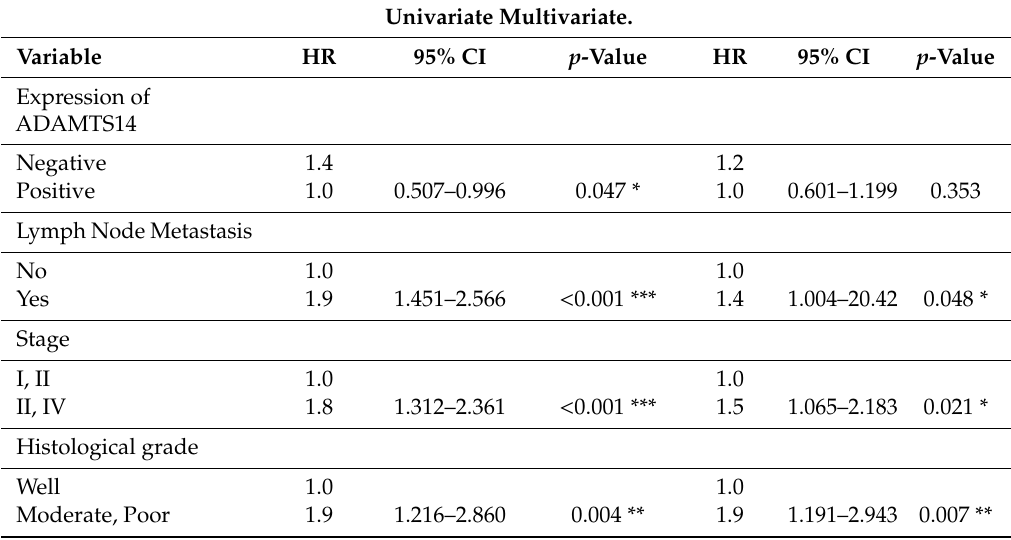
Table 3. The e ff ect of clinicopathologic factor and ADAMTS14 expression on mortality density and adjusted hazard ratio among OSCC